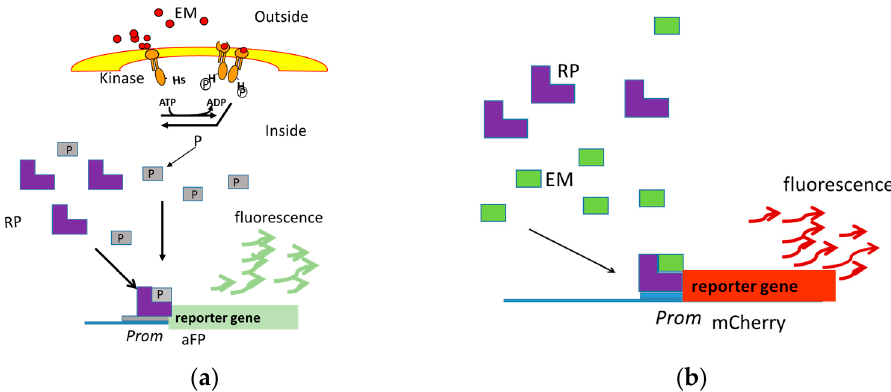
Figure 1. The reporter genes aFP and mCherry are transcribed when the effector molecule present in the cell’s environment is recognized by a transcriptional regulator that is capable of binding to DNA, modifying the transcription. Two-Component Systems ( a ) and Two-Domain Proteins ( b ) are systems implicated in effector molecule recognition. EM, Effector Molecule; P, Phosphate; RP, Receptor Protein; Prom , Promotor; aFP , Anaerobic Fluorescent Protein.